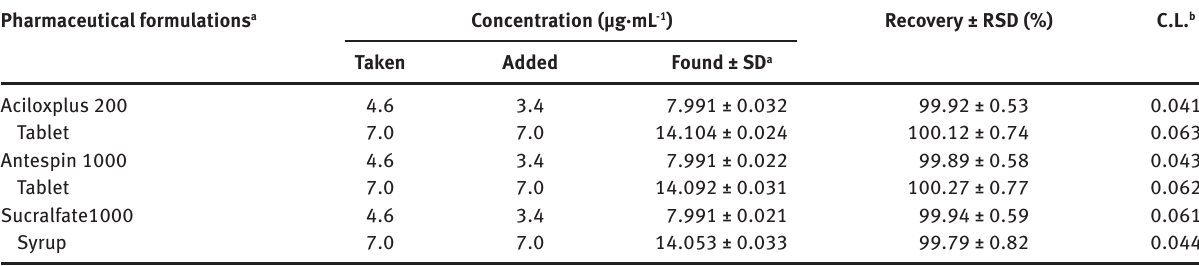
Table 7: Spiked procedure – assessment the determination of Bi 3+ in dosage forms using the proposed method Pharmaceutical formulations a